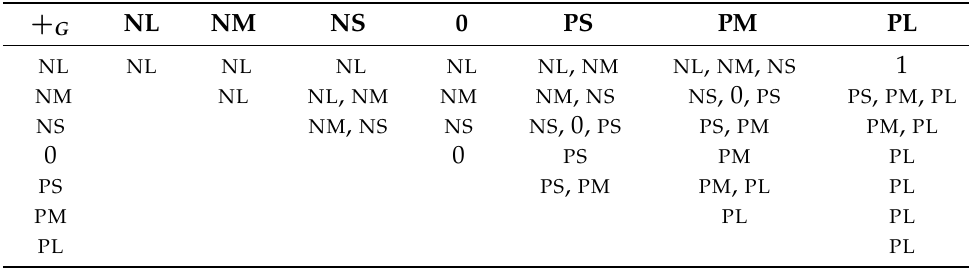
Table 1. Composition of components of L G .